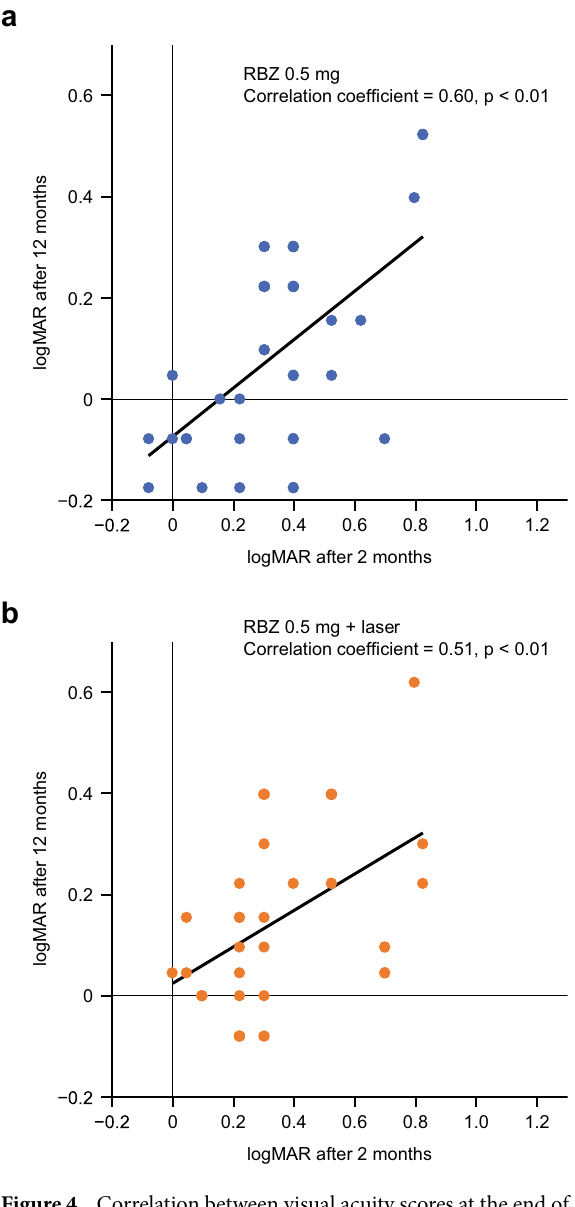
Figure 4. Correlation between visual acuity scores at the end of Month 2 and at Month 12. ( a ) Ranibizumab 0.5 mg monotherapy. ( b ) Ranibizumab 0.5 mg plus laser. logMAR logarithm of the minimum angle of resolution, RBZ